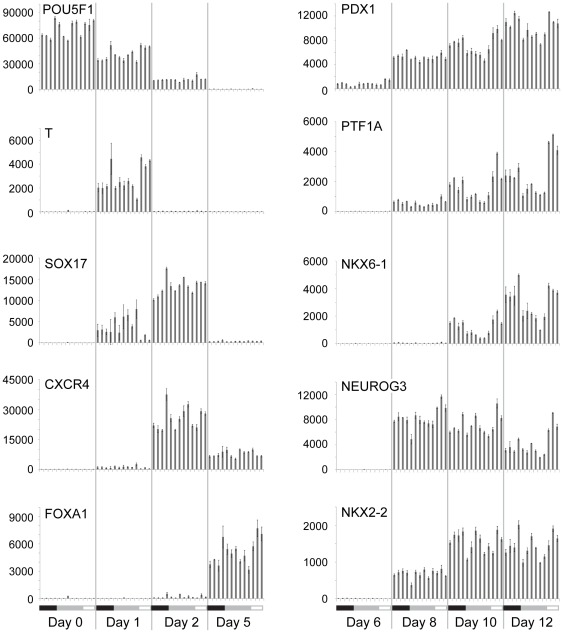
Digital mRNA profiling of scaled pancreatic differentiation runs.The dynamics of gene expression demonstrated that undifferentiated cells (POU5F1) were directed through mesendoderm (Brachyury: T), definitive endoderm (SOX17, CXCR4), primitive gut tube (FOXA1), posterior foregut (PDX1), to form pancreatic epithelium (NKX6-1, PTF1A), and endocrine cells (NEUROG3, NKX2-2). Precise temporal control and consistency between manufacturing runs indicated a reproducible and robust specification of each lineage. The plots are ordered according to CyT49 cell bank (left to right): black bar (MCB4: Expt #18–21), grey bar (RCB-Dw: Expt #25–30), open grey bar (WCB4B: Expt #35–37). The average and standard deviation of three biological replicates are plotted. Additional data is shown in Figs. S6, S7.